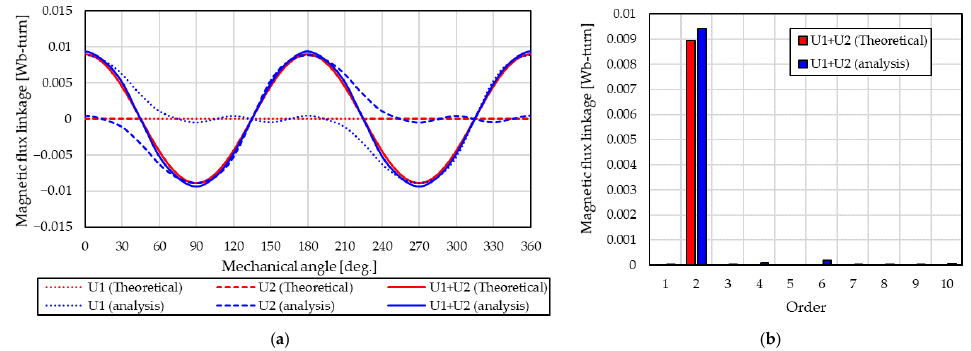
Figure 16. Theoretical and analytical magnetic flux linkage at no load: ( a ) flux linkage waveform of the U-phase, U1-phase, and the U2-phase; ( b ) FFT analysis result of the U-phase.